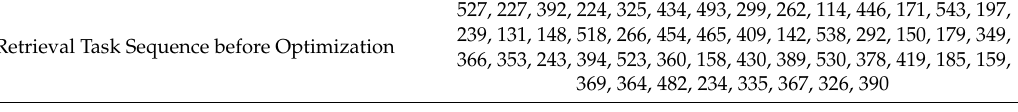
Table A2. The list of retrieval tasks before and after optimization when Task = 50.